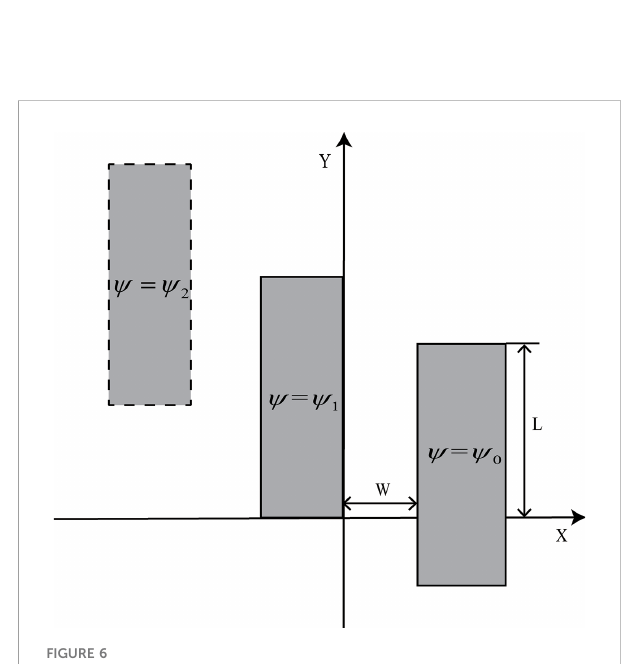
FIGURE 6 Schematic map of the passage between the two nearby